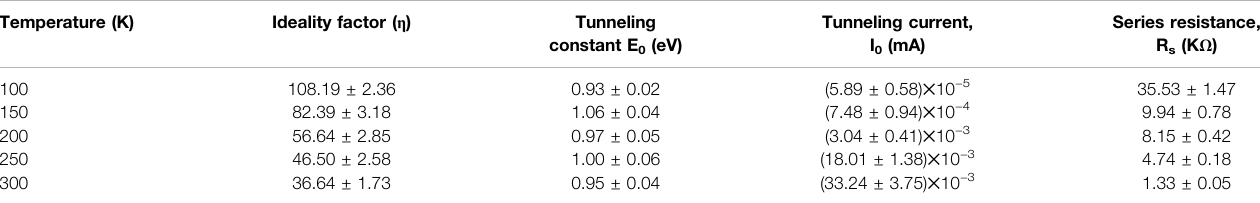
TABLE1| Temperaturedependenceofextractedparameters(after fi ttingtheI-Vcurvewithdiodeequation)suchasidealityfactor,tunnelingconstant,tunnelingcurrent,and series resistance of the NZFO/MgO/p-Si heterostructure. Temperature